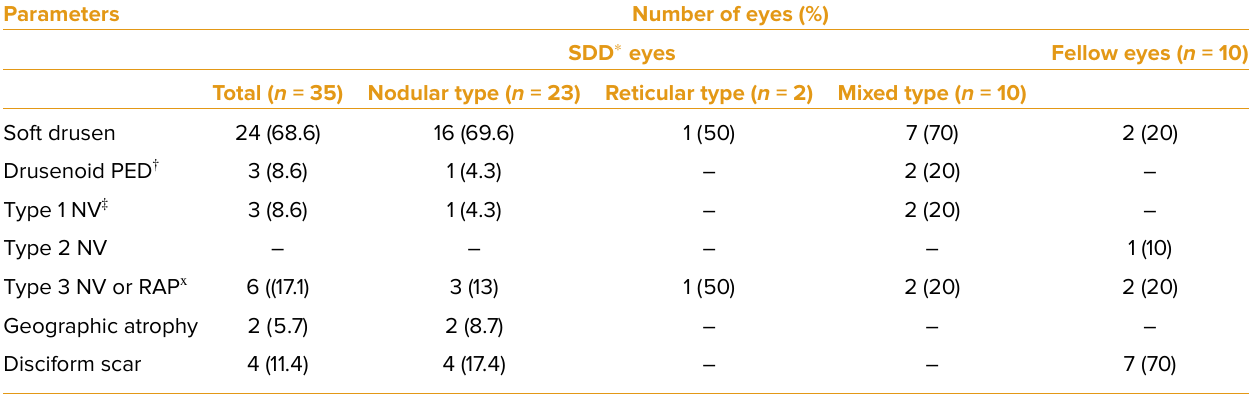
Table 2. Retinal features in eyes with subretinal drusenoid deposits